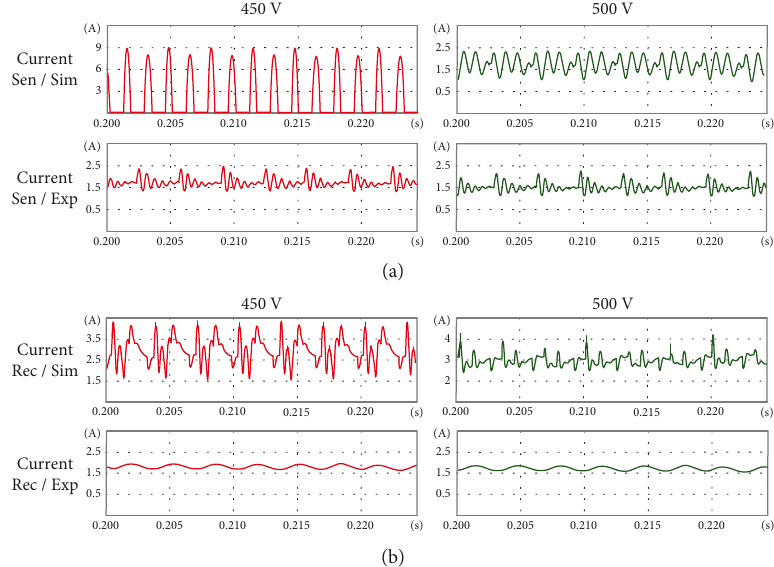
Figure 19: Comparison of the current waveforms based on the voltage conditions. (a) Comparison of the sending side current waveforms and (b) comparison of the receiving side current waveforms.